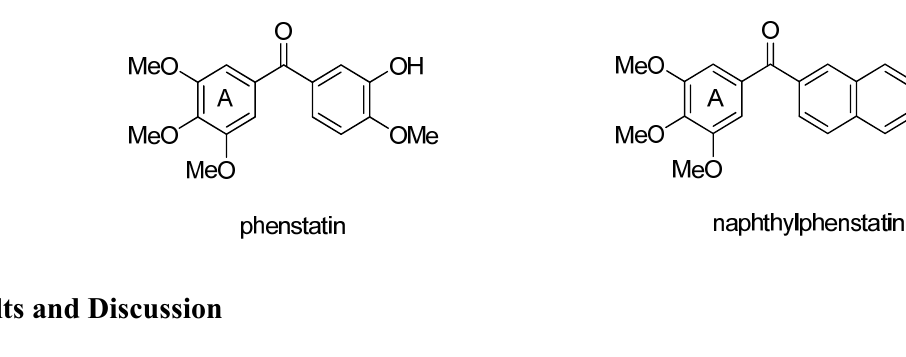
Figure 1. Structure of phenstatin and